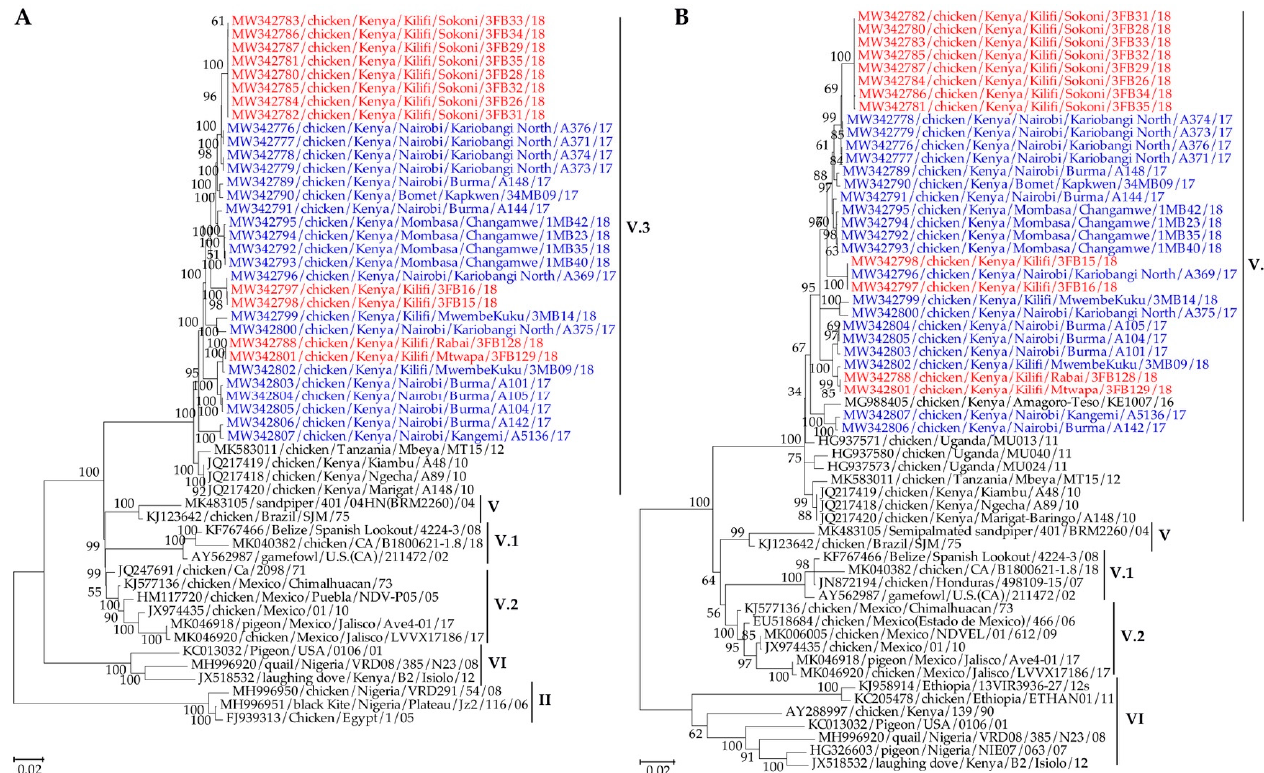
Figure 3. ( A ) Phylogeny of the complete genome nucleotide sequences and ( B ) fusion gene nucleotide sequences of 32 NDV isolates reported in the current study in comparison to related isolates in GenBank. The sequences of the 20 and 12 NDV isolates isolated from the LBMs and BPFs are shown in blue and red fonts, respectively. The evolutionary history was inferred by using the ML method based on the GTR model [47]. The analysis involved 53 and 59 nucleotide sequences for the complete genomes and the fusion genes, respectively. Codon positions included were 1st+2nd+3rd+Noncoding. All positions with less than 95% site coverage were eliminated, i.e., fewer than 5% alignment gaps, missing data, and ambiguous bases were allowed at any position (partial deletion option). The final datasets had 14795 and 1662 positions for the complete genomes and the fusion genes, respectively. Evolutionary analyses were conducted in MEGA X [37].